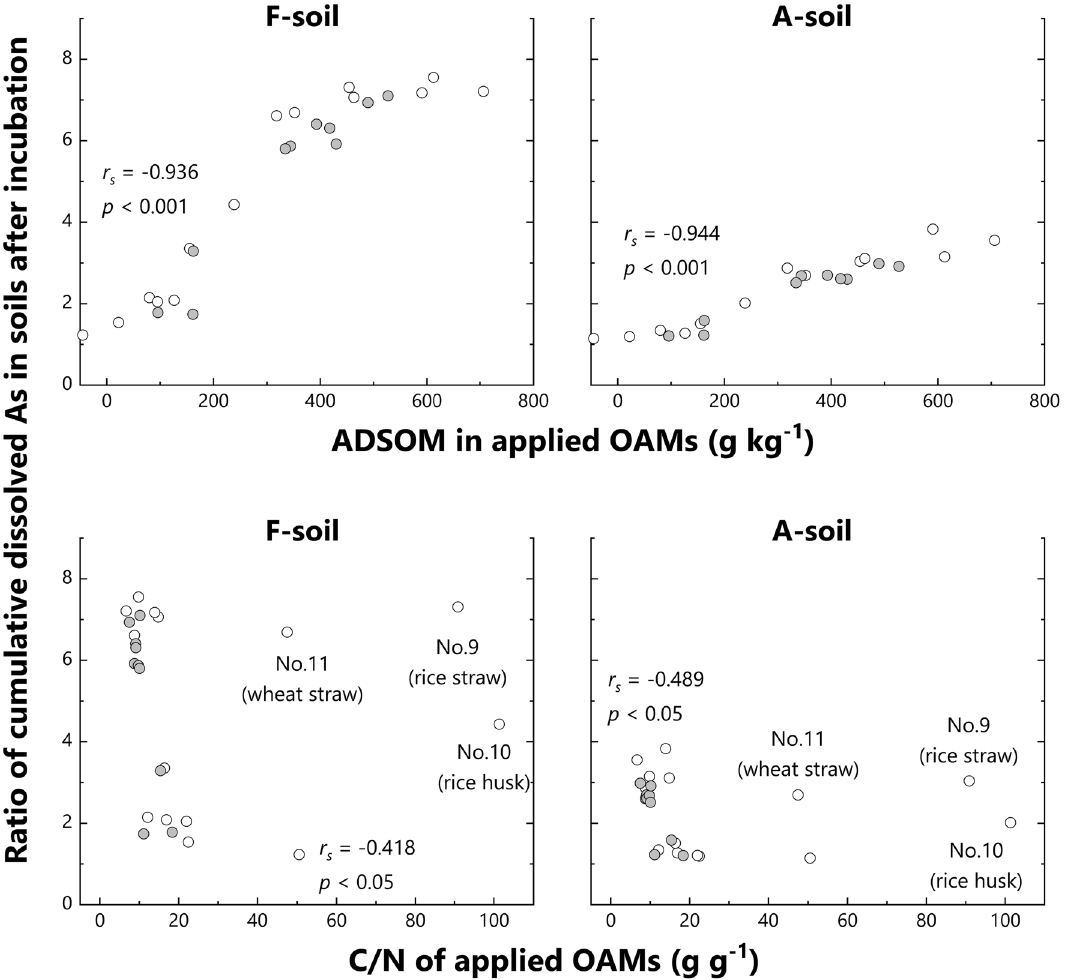
Figure 4. Relationship between the ratio of cumulative dissolved As in soils and acid-detergent soluble organic matter (ADSOM) contents, and carbon to nitrogen ratio (C/N) of organic amendments (OAMs) applied to the soils. The ratio of cumulative dissolved As is defined as the ratio of cumulative dissolved As in soils with each OAM obtained after the whole incubation period to that of control soils (i.e., soils without OAM). No. 9, No. 10, and No. 11 are soils with rice straws, rice husks, and wheat straws, respectively, which have abundant ADSOM and high C/N. Data are shown as the average of duplicates. r s denotes Spearman’s rank correlation